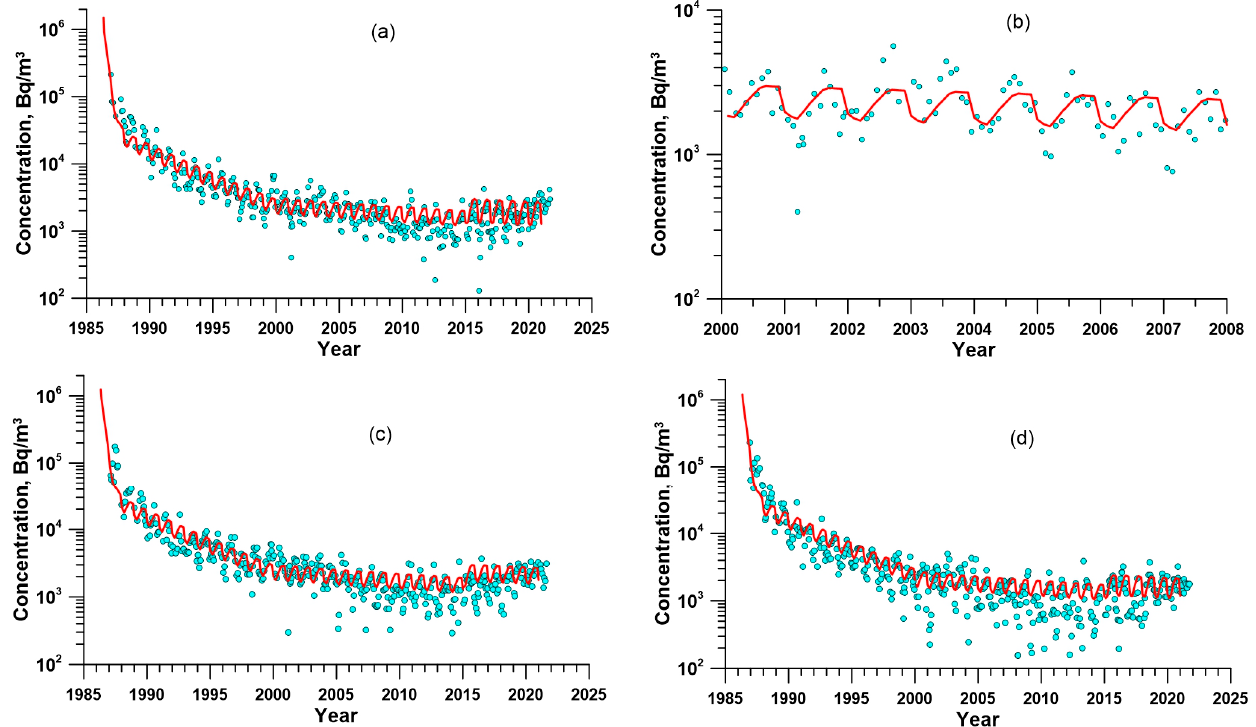
Figure 3. Calculated (line) and measured (dots) concentrations of 137 Cs in the water of the CP: ( a ) Sector 1 with ( b ) zoom-in from 2000 to 2008 to show seasonal variations; ( c ) Sector 4; and ( d ) Sector 8.